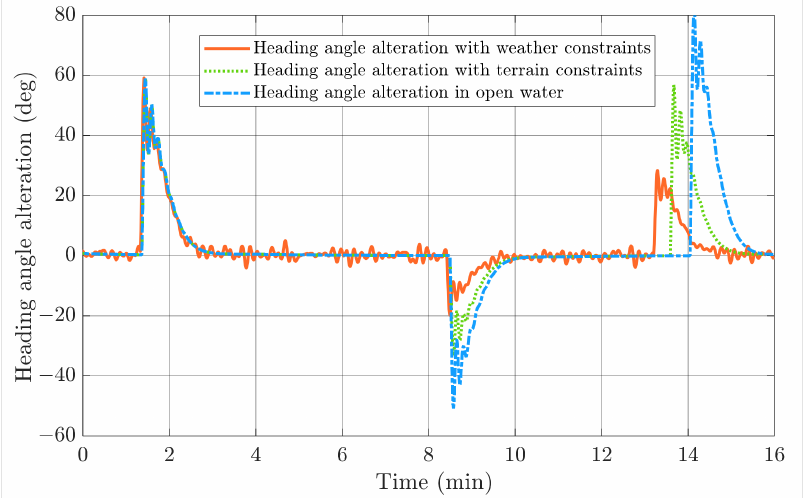
Figure 19. Collision avoidance paths and actual trajectories of USV in a head-on encounter situation with different constraints.